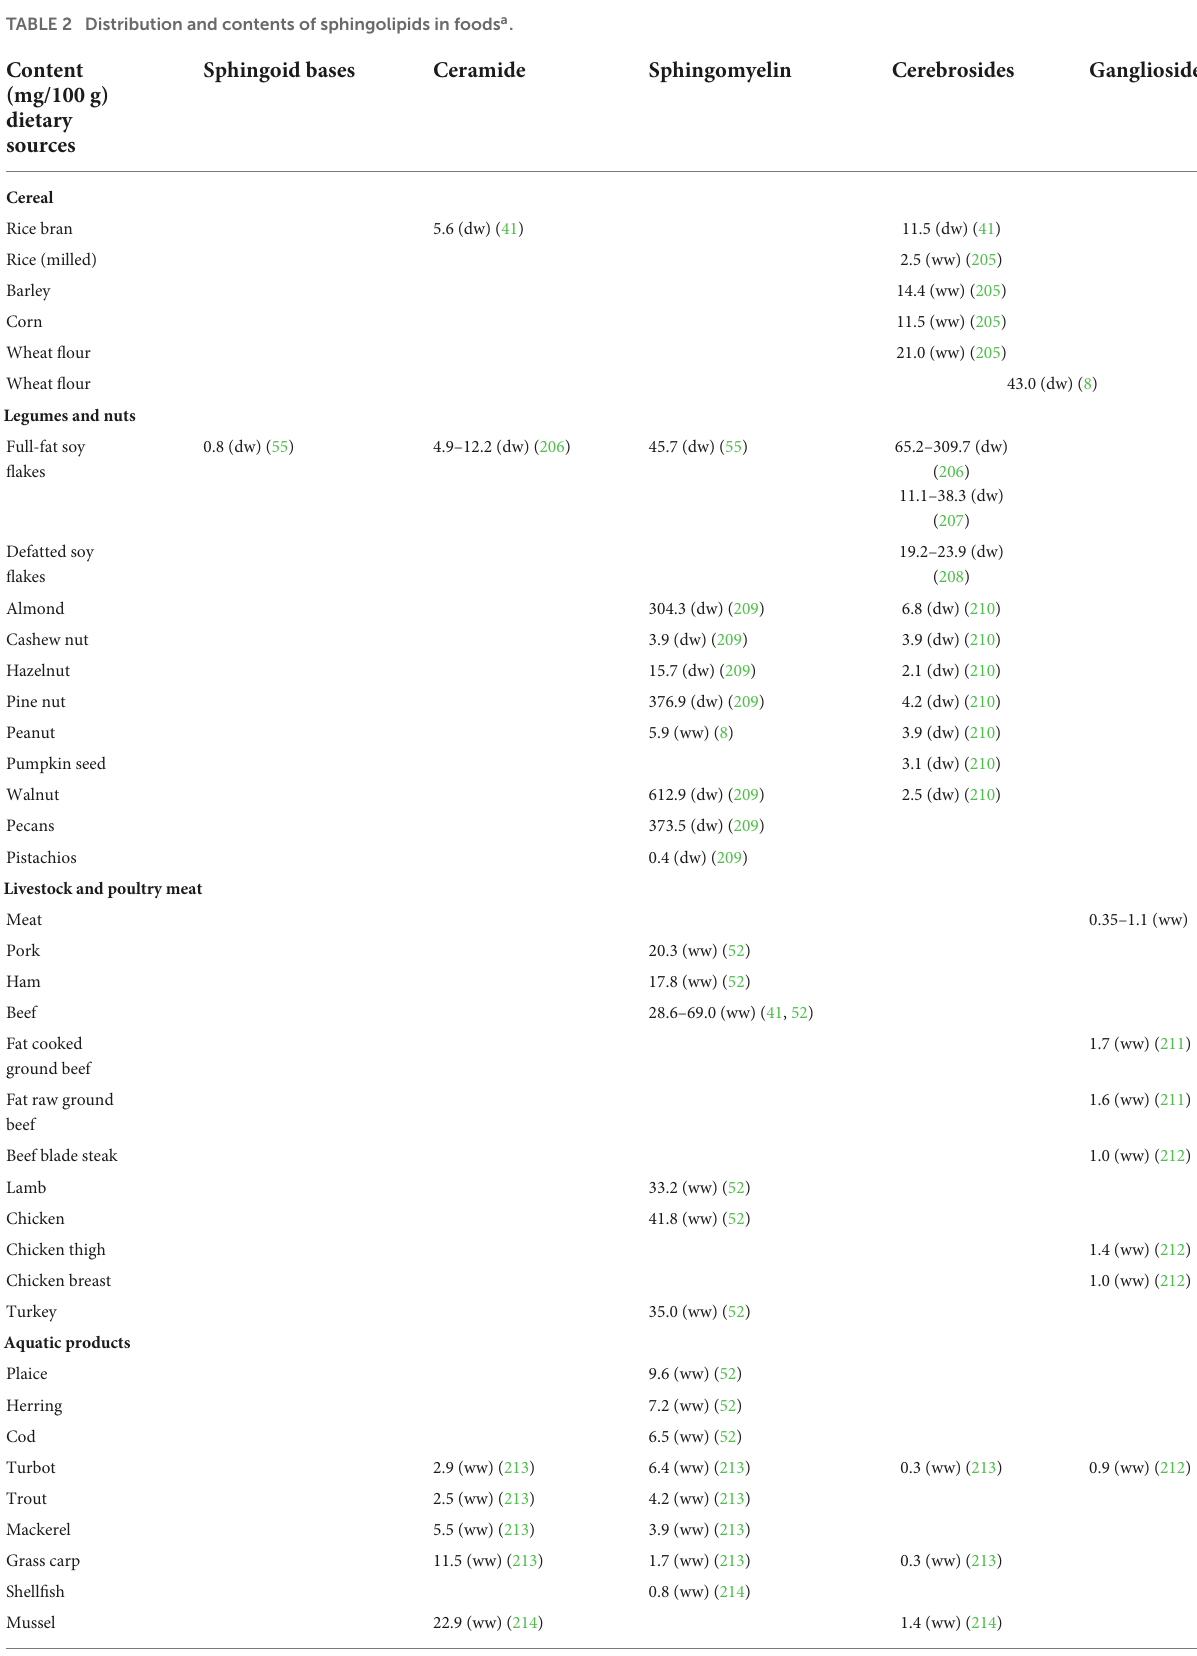
TABLE 2 Distribution and contents of sphingolipids in foods a